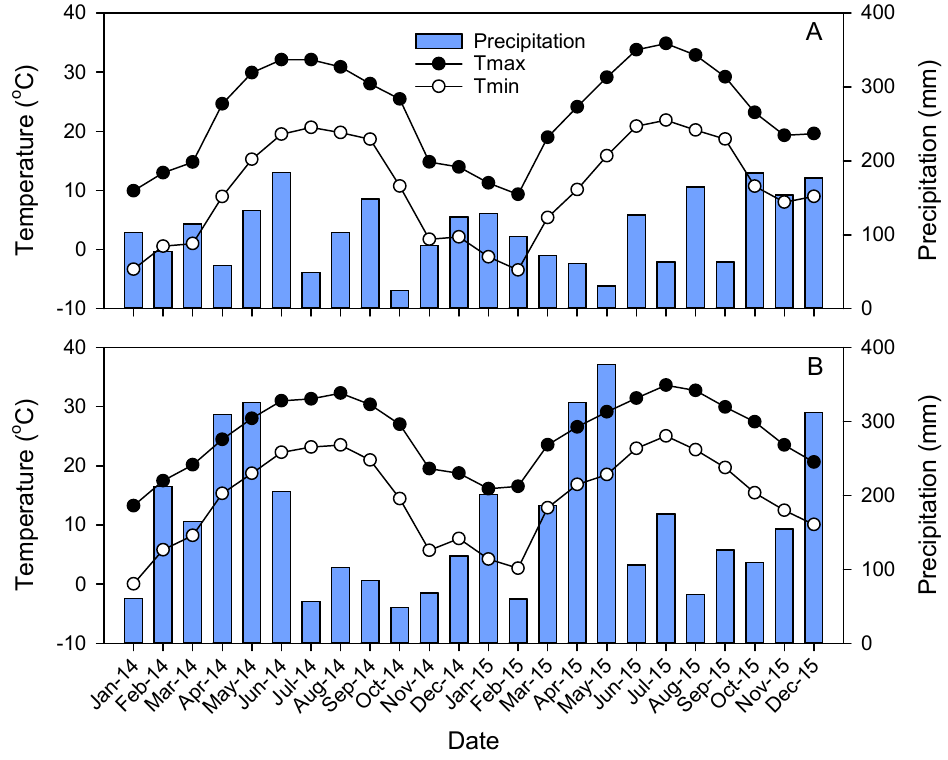
Figure 2. Average monthly minimum (Tmin) and maximum (Tmax) temperatures and total monthly precipitation at the North Carolina ( A ) and Mississippi ( B ) provenance test sites during the 2-year study.